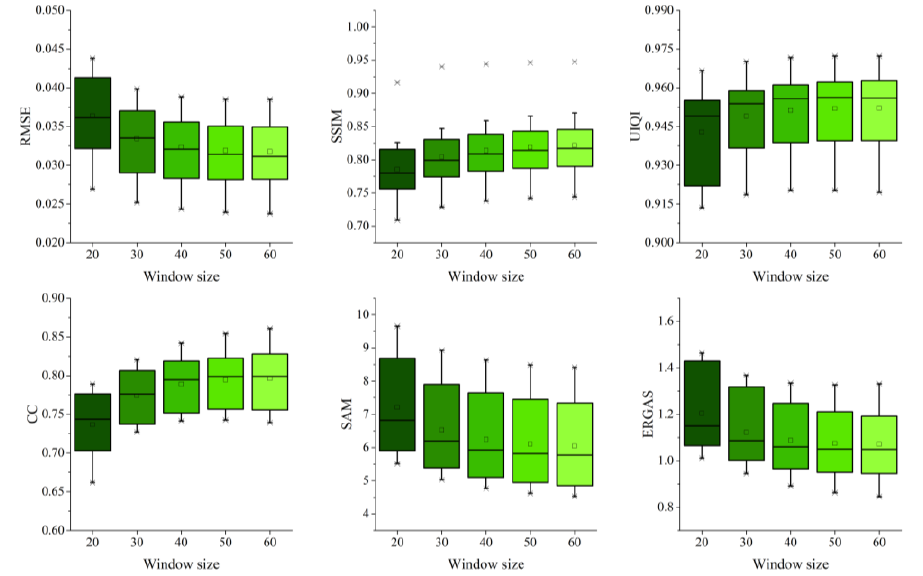
Figure 14. Fusion performance results of the CIA site at different window sizes.